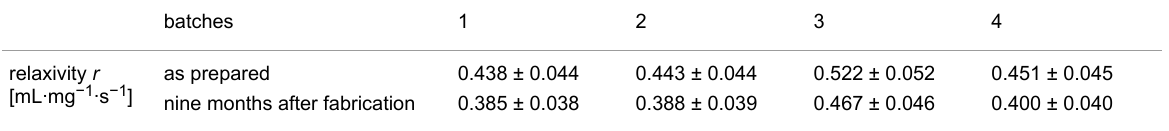
Table 2: Relaxivities of four different batches: as prepared (row 1) and nine months after fabrication (row 2).